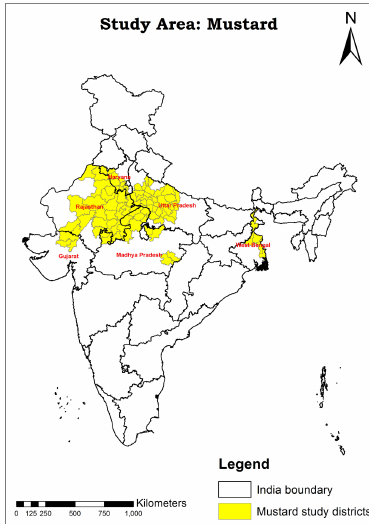
Figure1. Rapeseed & Mustard growing districts of India under FASAL Project